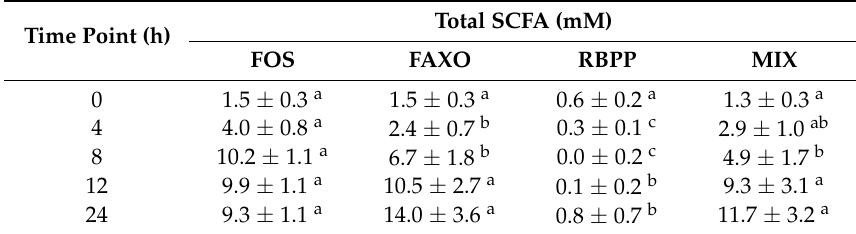
Table 2. Total production of SCFA (Short-Chain Fatty Acid) during in vitro fermentation with human fecal